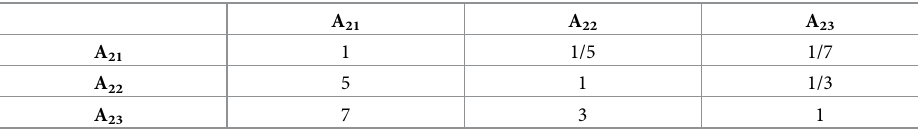
Table 7. Pairwise comparison matrix of the Shili